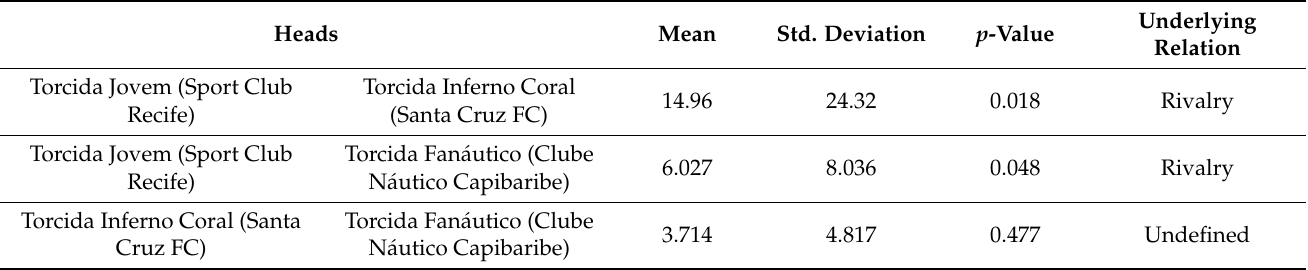
Table 3. The relations among the three